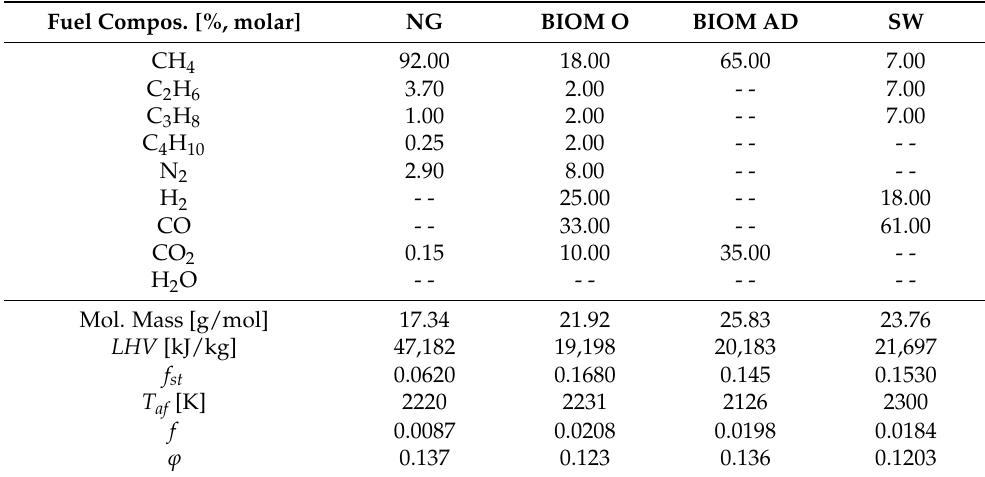
Table 2. Natural gas and biogas chemical properties.